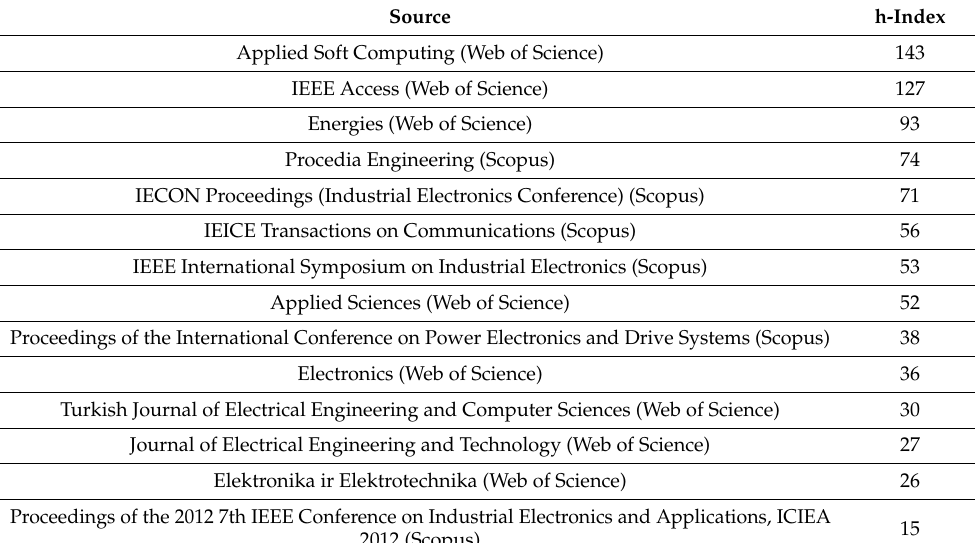
Table 4. Sources indexed in Scopus and Web of Science with the highest